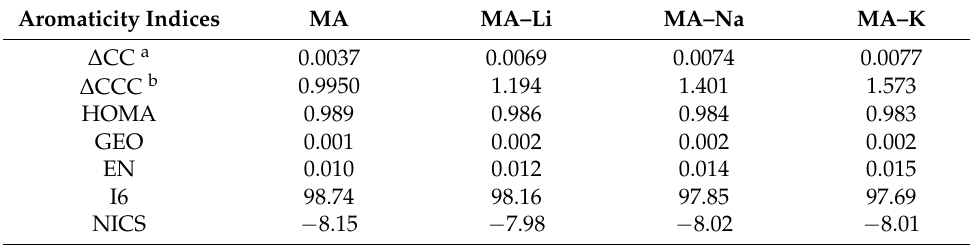
Table 4. Aromaticity indices for mandelic acid and lithium, sodium, and potassium mandelate. Aromaticity Indices